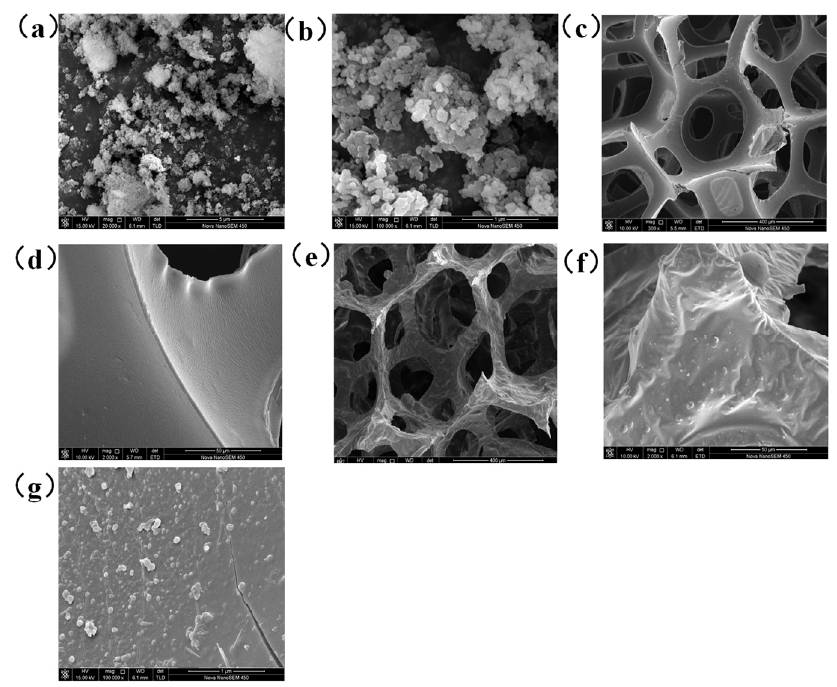
Figure 4. SEM images of nano-HAp ( a , b ), pristine PU sponge ( c , d ) and nano-HAp/PU sponge ( e – g ).